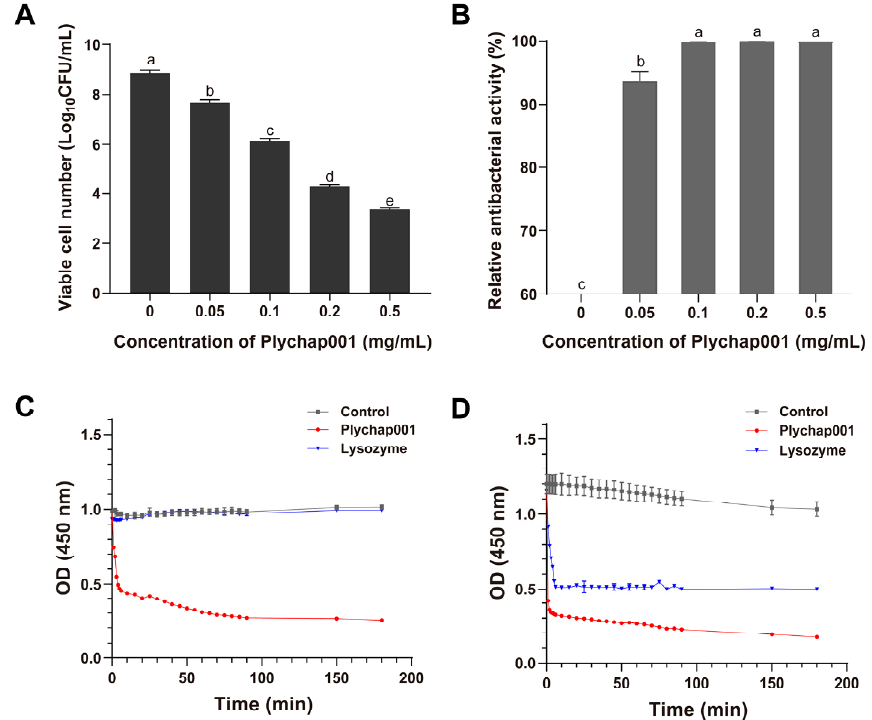
Figure 3. Antibacterial activity of recombinant Plychap001. ( A ) Statistical results of viable cell number after treatment with different concentrations of Plychap001. ( B ) Relative antibacterial activity was calculated as percentage by dividing the residual viable cells number with total cell number. ( C , D ) Results of turbidity reduction assays. ( C ) OD 450 nm of V. parahmolyticus suspensions treated with Lysqdvp001 or Lysozyme. ( D ) OD 450 nm of V. parahmolyticus suspensions pretrated with EDTA and treated with Lysqdvp001 or Lysozyme. Different letters (a–e) on the columns indicated significant difference between each other at p < 0.01 level. Data were shown as the mean ± SEM for n = 3.